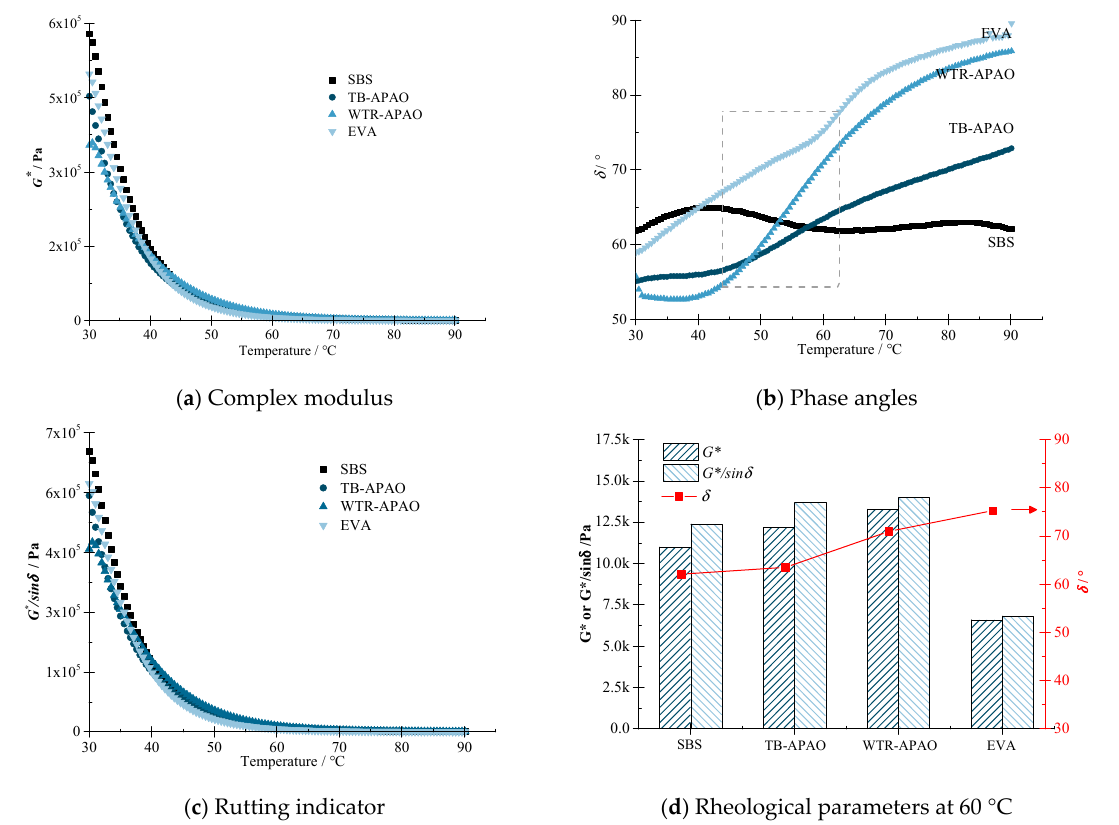
Figure 1. High-temperature rheological properties of asphalts via temperature sweep tests: ( a ) complex modulus, ( b ) phase angles, ( c ) rutting indicator, and ( d ) rheological parameters at 60 °C.